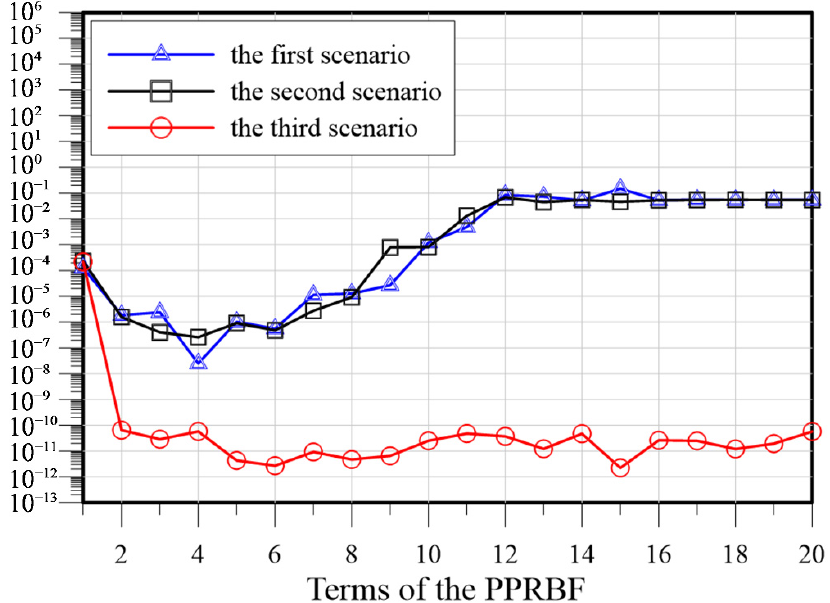
Figure 3. RMSE of the three scenarios for locating the sources.